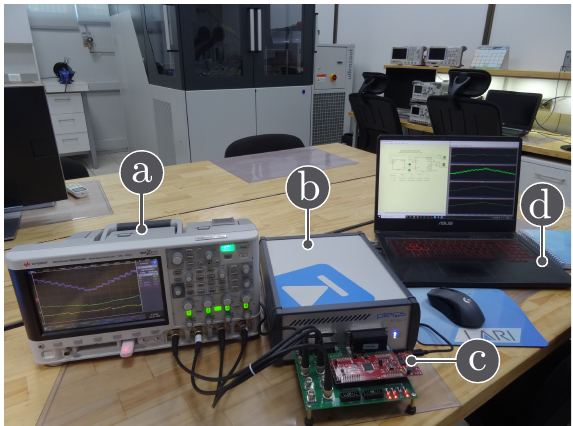
Figure 5. The experimental setup of the hardware in-the-loop tests: ( a ) oscilloscope, ( b ) PLECS RT-box, ( c ) Texas Instruments LAUNCHXL-F28069M, ( d )